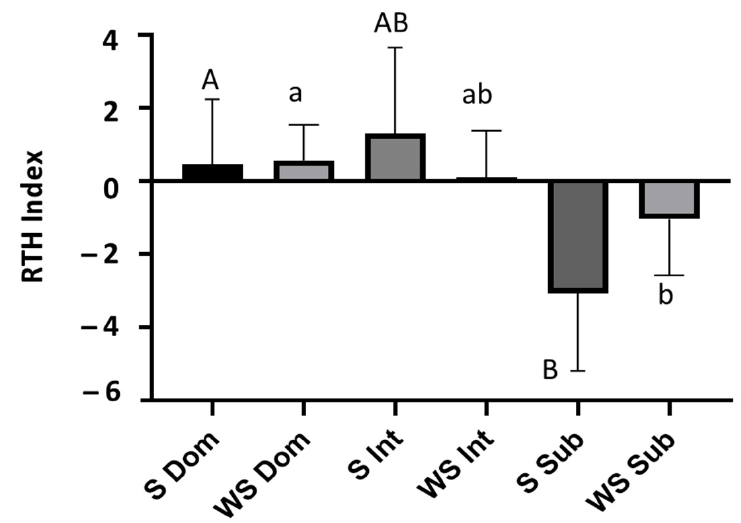
Figure 5. Rest the Head (RTH index) in Senegalese sole juveniles for dominant ( n = 6), intermediate ( n = 12) and subordinate fish ( n = 6) per environment. S = Sand; WS = Without Sand; Dom = dominant; Int = Intermediate; Sub = Subordinate. Data are shown as mean ± SD. Different letters indicate significant differences within the same environment (two-way ANOVA; p < 0.05).